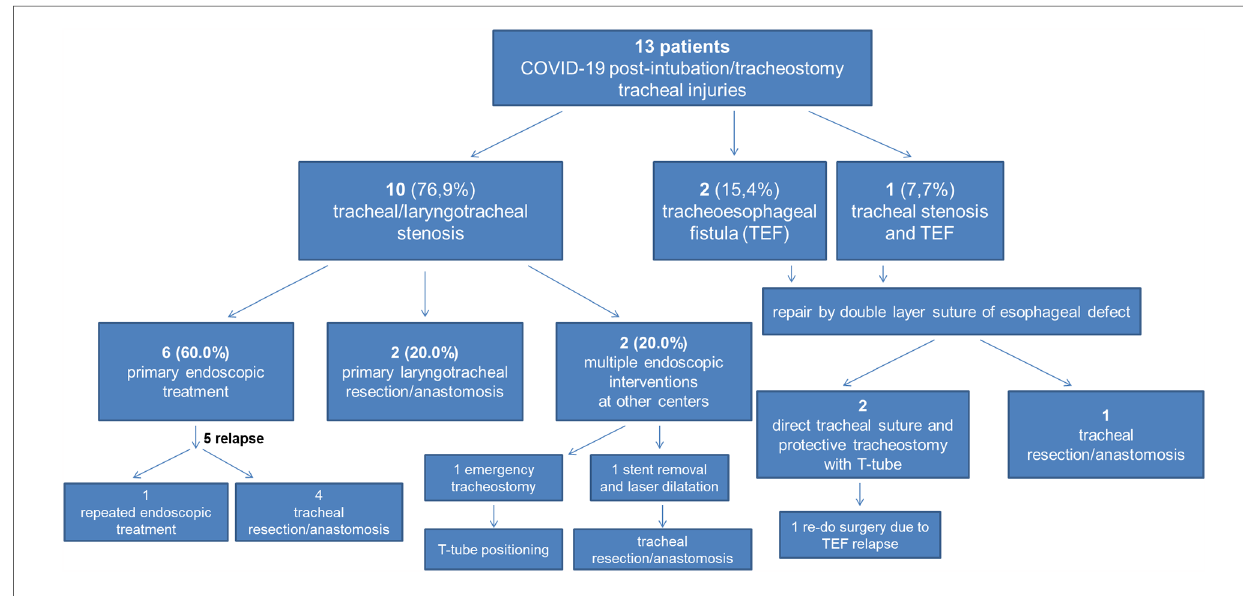
FIGURE 1 Treatment algorithm and outcomes in our patients with COVID-19 post-intubation/tracheostomy tracheal